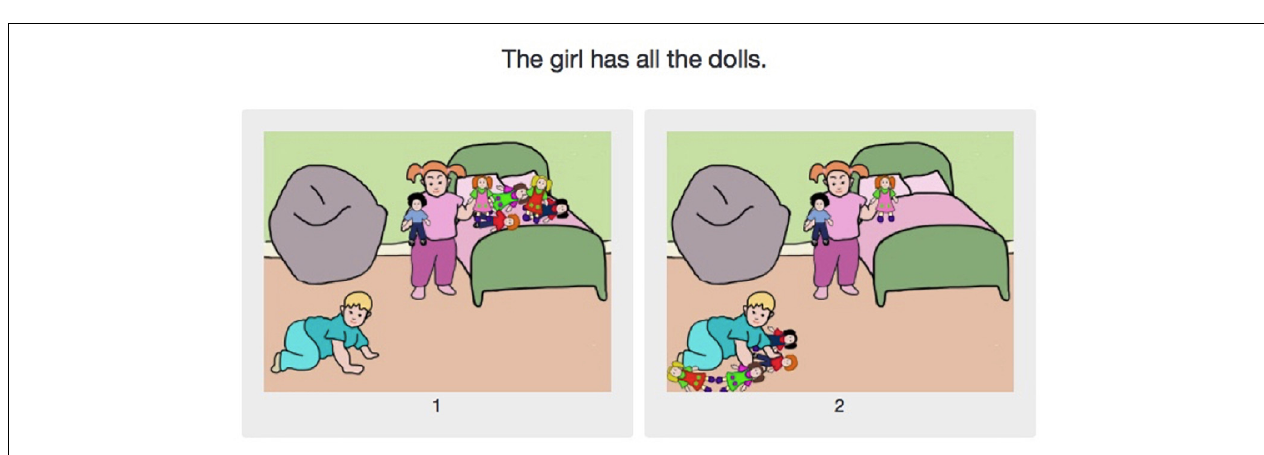
FIGURE 9 | Experiment 2: The only some condition (the image verifying the sentence is on the left, the image falsifying it on the right).